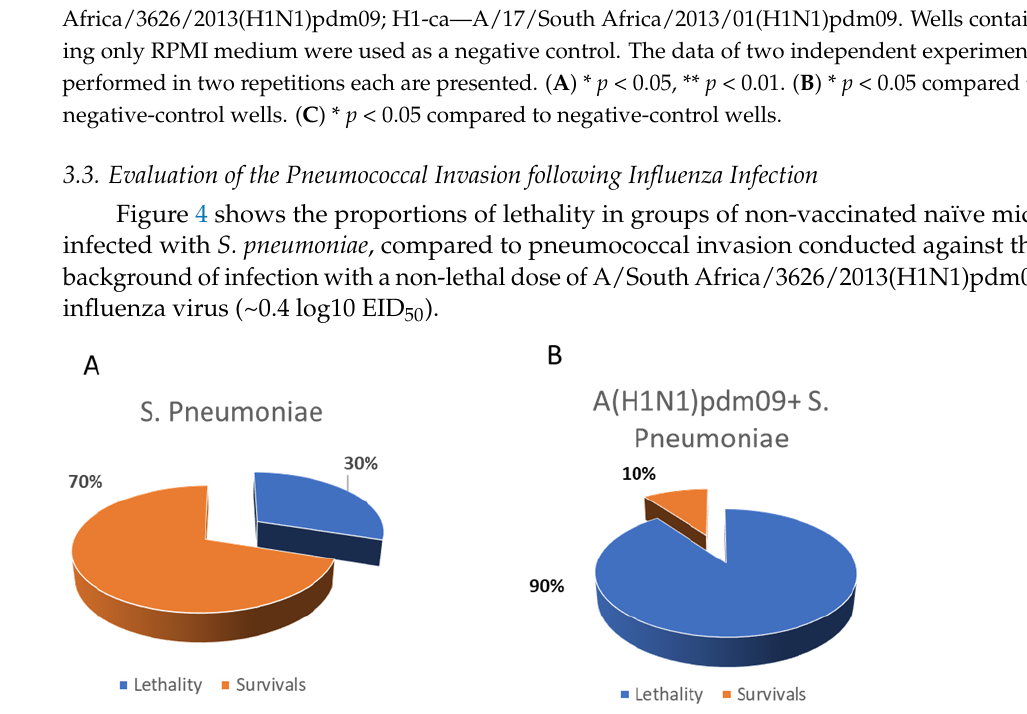
Figure 4. Post-influenza pneumococcal infection of the intact mice. ( A ) Challenge using 5 × 10 4 CFU of S. pneumoniae ( n = 10). ( B ) Challenge with pandemic influenza strain A/South Africa/3626/2013 (H1N1)pdm09, followed by S. pneumoniae infection 3 days apart.